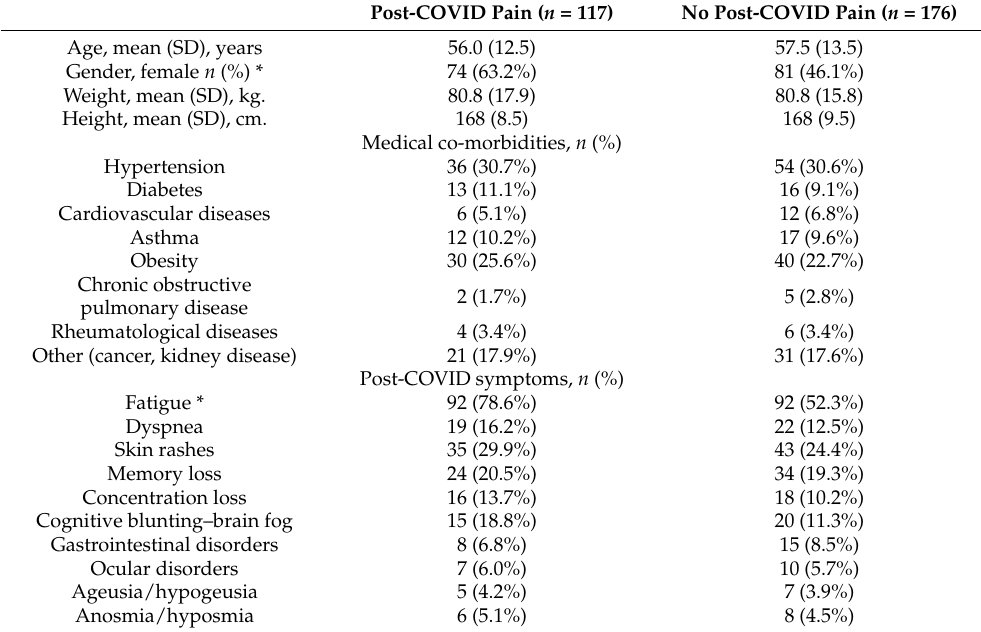
Table 1. Demographic, previous co-morbidities and other post-COVID symptoms in COVID-19 survivors according to the presence or absence of post-COVID